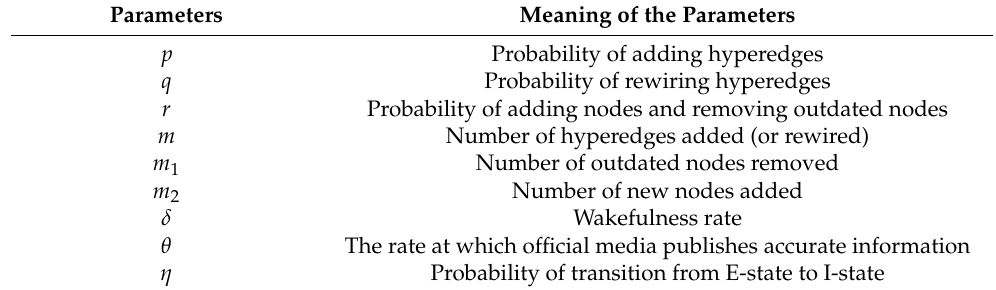
Figure 1. Schematic diagram of dynamic network evolution. ( i – iii ) are parallel relationships, one of them will happen at the next time step t + 1. ( i ) add a new hyperedge e 3 consisting of nodes 3, 4, and 5; ( ii ) randomly select a link e 2 containing node 2 to disconnect and then form a new hyperedge e 4 with nodes 3 and 4; ( iii ) Node 5 exits, and nodes 6 and 7 enter the system. Table 1. The meaning of